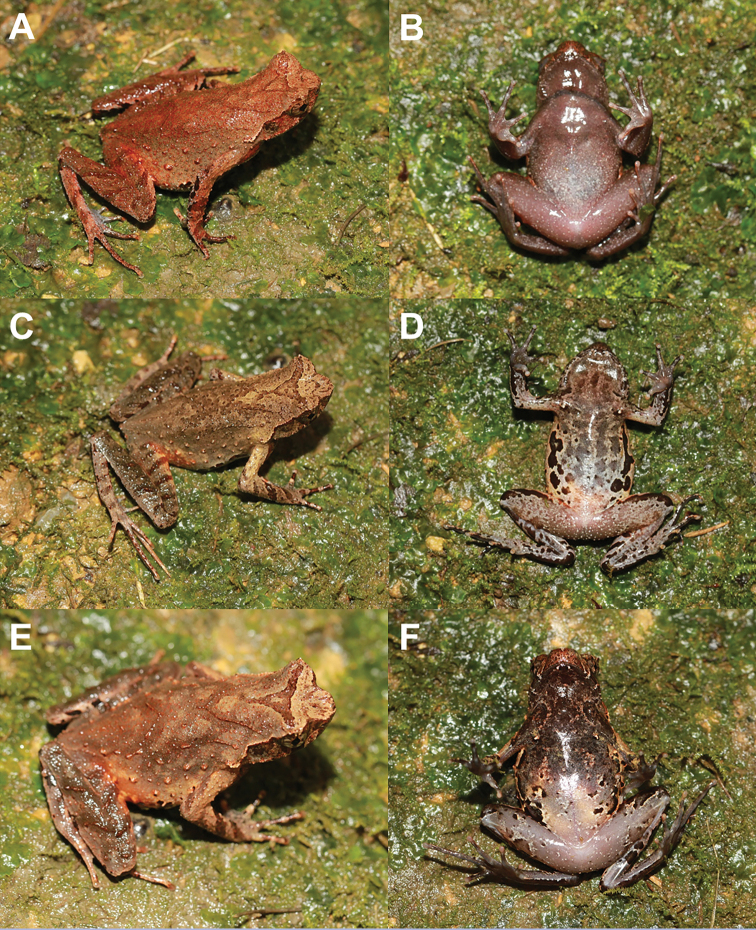
Color variation in Megophrys
chishuiensis sp. nov. A dorsolateral view of the female specimen CIBCS20190518027 B dorsolateral view of the female specimen CIBCS20190518030 C dorsal view of the female specimen CIBCS20190518025 D ventral view of the male specimen CIBCS20190518019 E ventral view of the female specimen CIBCS20190518030 F ventral view of the female specimen CIBCS20190518025.